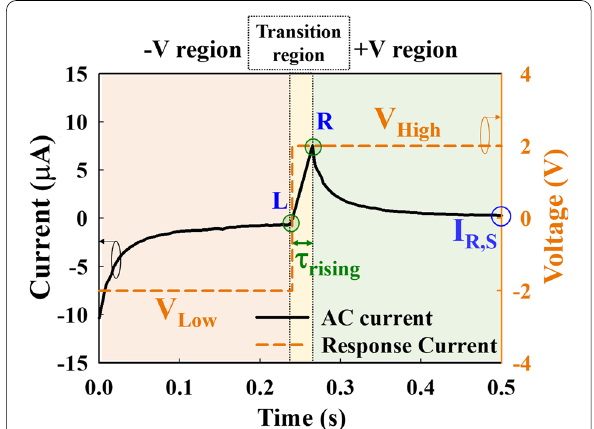
Fig. 5 Time evolution of I response and the input voltage. V Low and V High represent the negative and positive voltages of the input AC voltage,